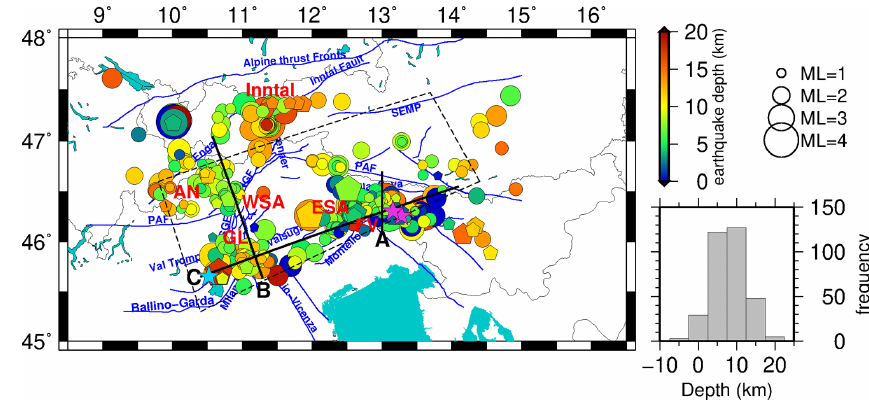
Figure 11. Distribution of the 335 well-located earthquakes in the target area after McMC inversion (single-event mode). Circles are earth- quakes that were incorporated in the simultaneous inversion, and pentagons are 43 additional earthquakes with fewer picks. The color and size of the circles indicate the depth and magnitude of the earthquakes, respectively (magnitude is taken from national catalogs). The dashed black box indicates the periphery of the SWATH-D network. Purple stars show the location of Friuli earthquake of 6 May 1976 ( M L 6.4) and its major aftershock on 15 September 1976 ( M L 6.1) (Slejko, 2018), and the blue star is the Salò earthquake on 24 November 2004 ( M L 5.2; Viganò et al., 2015). Black lines indicate cross sections shown in Fig. 12. Faults are compiled from geological maps of the Italian geological survey, including Avanzini et al. (2010); Bartolomei et al. (1967); Bosellini et al. (1967); Braga et al. (1971); Castellarin et al. (1968, 2005); and Dal Piaz et al. (2007) and complemented by fault traces published in Handy et al. (2010) and Schmid et al. (2004, 2008). Abbreviations are as follows: ESA stands for eastern southern Alps, WSA stands for western southern Alps, FV stands for Friuli-Venetia region, GL stands for Giudicarie–Lessini region, AN stands for Austroalpine nappes, PAF stands for Periadriatic Fault, NGF stands for northern Giudicarie Fault, SGF stands for southern Giudicarie Fault. The histogram on the right side indicates the depth distribution of the earthquakes in the